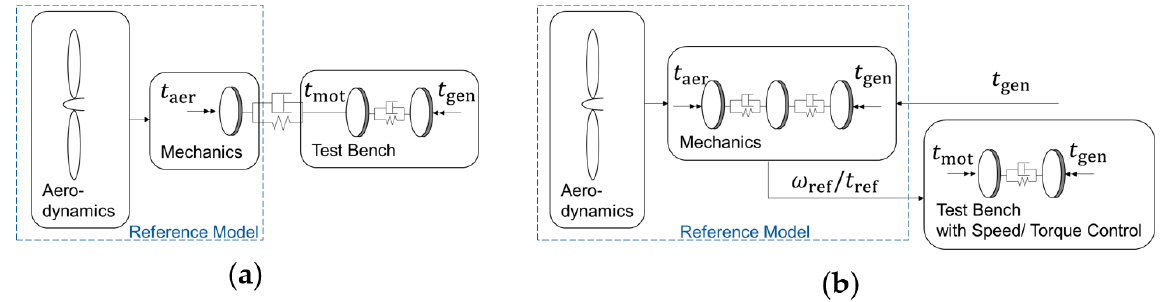
Figure 6. Mechanical-level HiL methods: Inertia Emulation ( a ) and Model Reference Control ( b ).